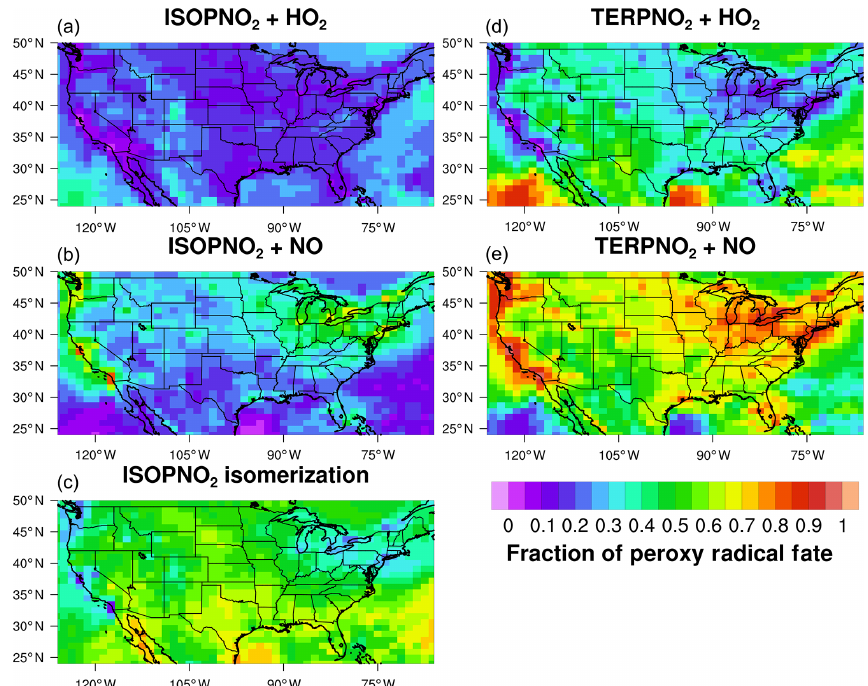
Figure 11. August 2013 average peroxy radical fate (fraction) below 2km using TS2 for the isoprene dihydroxy nitrate peroxy radical (ISOPNO 2 ) formed from isoprene first-generation hydroxy nitrate + OH ( a–c ) and terpene dihydroxy nitrate peroxy radical (TERPNO 2 ) produced from terpene unsaturated hydroxy nitrate + OH ( d,e